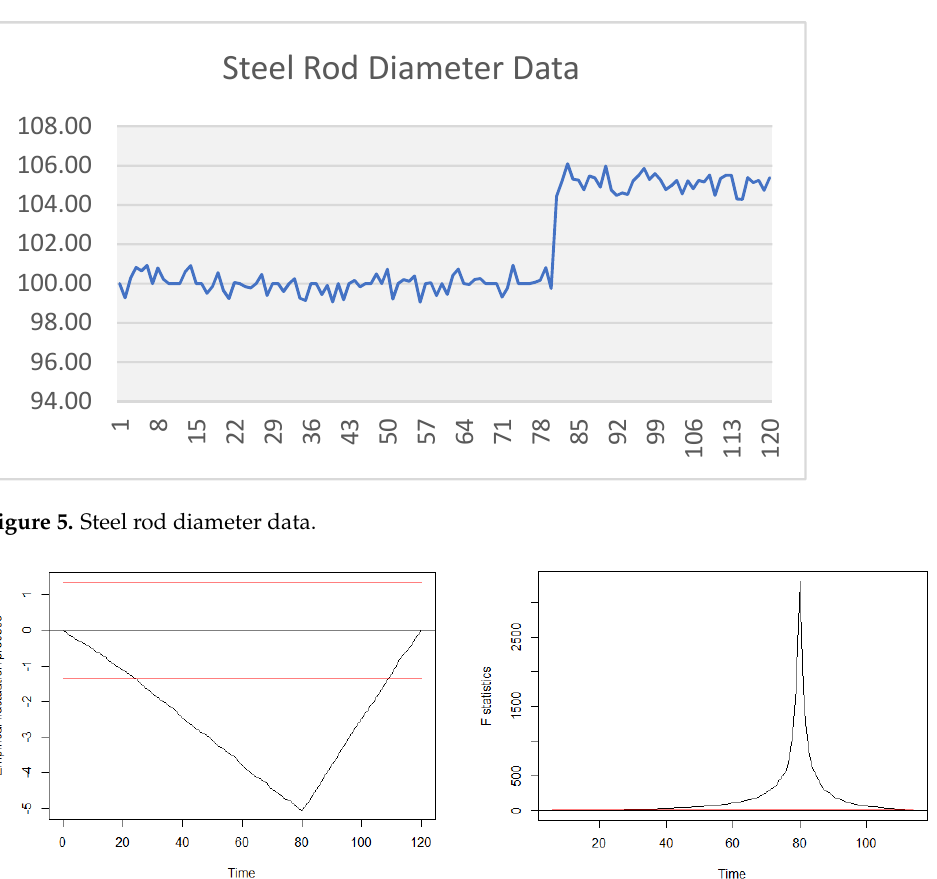
Table 2. Fitted segmented model details (minimal base model (level)).